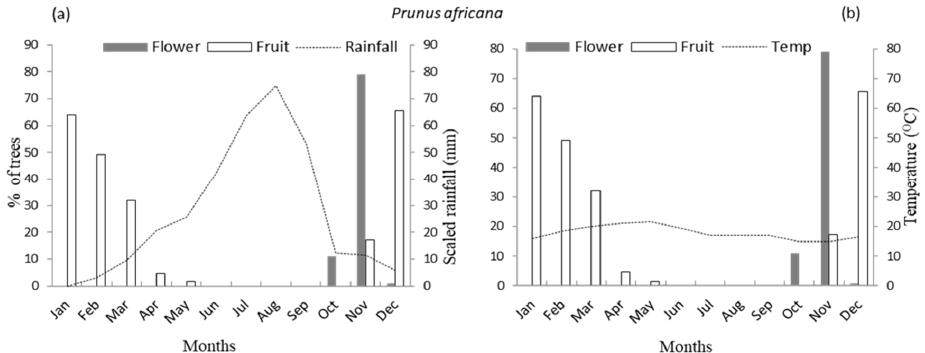
Figure 6. Percentage of flowering and fruiting of Prunus africana in relation: ( a ) to monthly precipitation and ( b ) temperature. In which Jan = January, Feb = February, Mar = March, Apr = April, May = May, Jun = June, Jul = July, Aug = August, Sep = September, Oct = October, Nov = November, Dec = December.